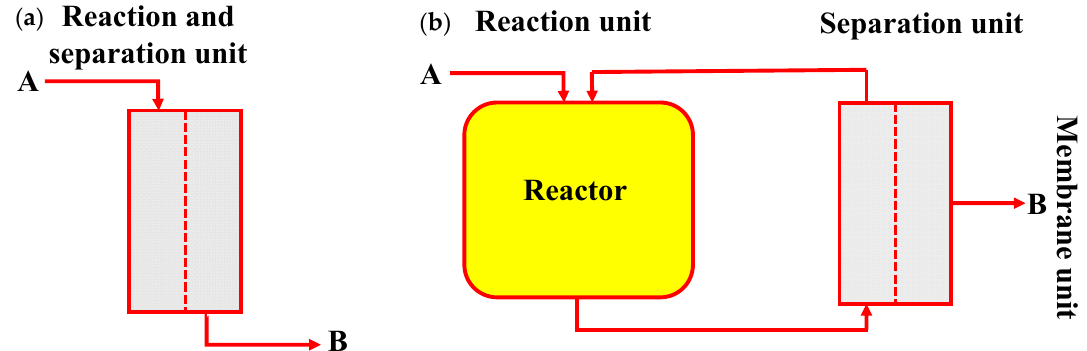
Figure 5. Membrane reactors: ( a ) reaction and separation are coupled in one unit (catalytic membrane reactor) and ( b ) reaction unit and membrane unit are separated (membrane recycle reactor).